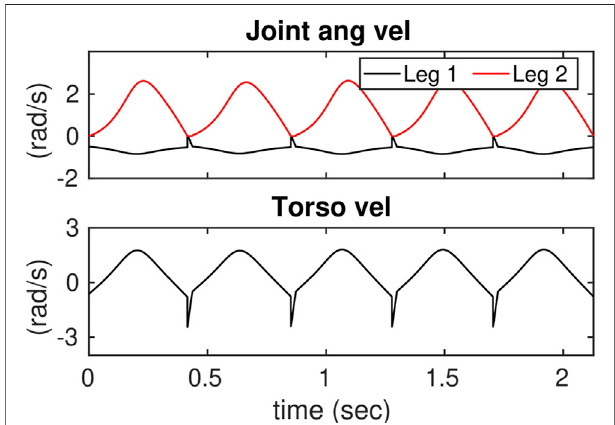
FIGURE 11 | Illustrates the closeup view of the constraint violations during 3D walking and jumping at t (cid:2) [9.5, 11.5]s. The reference trajectories violatetheconstraintsandthecontrollermanipulatestheappliedreferencesto prevent the constraints from being violated.